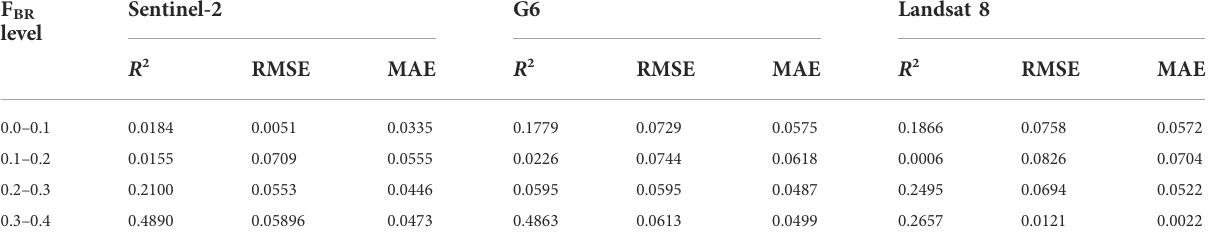
TABLE 4 Comparison of different levels of f BR estimation errors. F BR